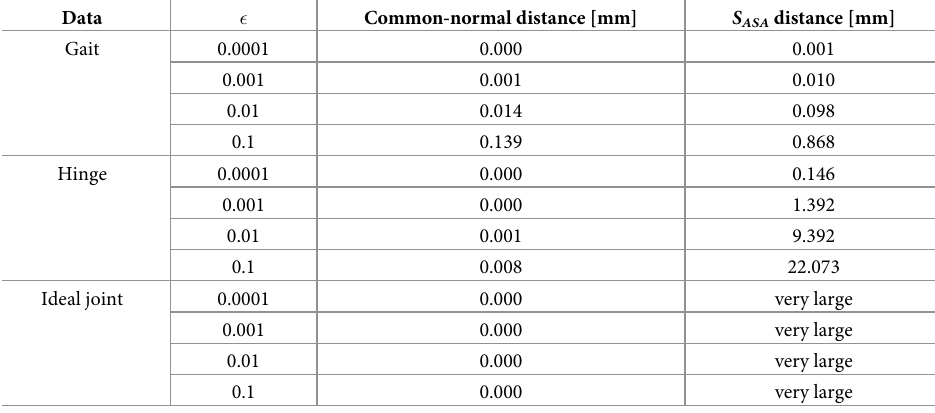
Table 1. Effect of the regularization: Common normal distance and position point ( S with respect to the non-regularized